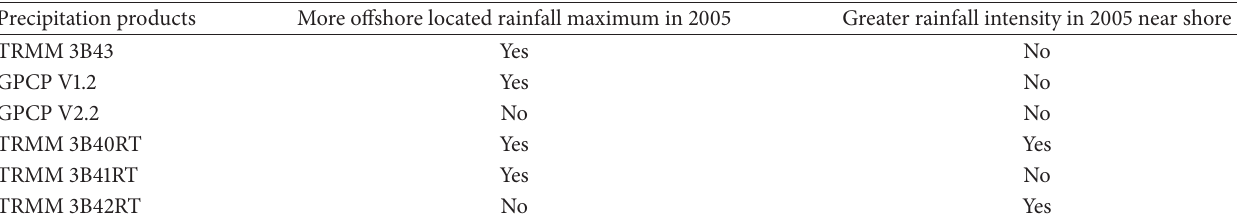
Table 2: Summary of the precipitation products in representing the differences in the offshore rainfall maximum and intensity in the east BoB between 2002 JJA and 2005 JJA. Precipitation